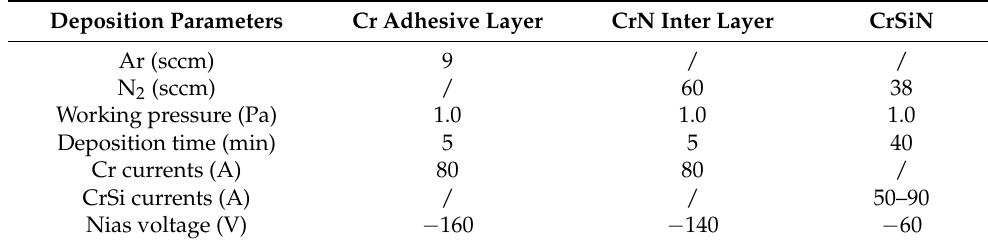
Table 1. Deposition parameters for CrSiN